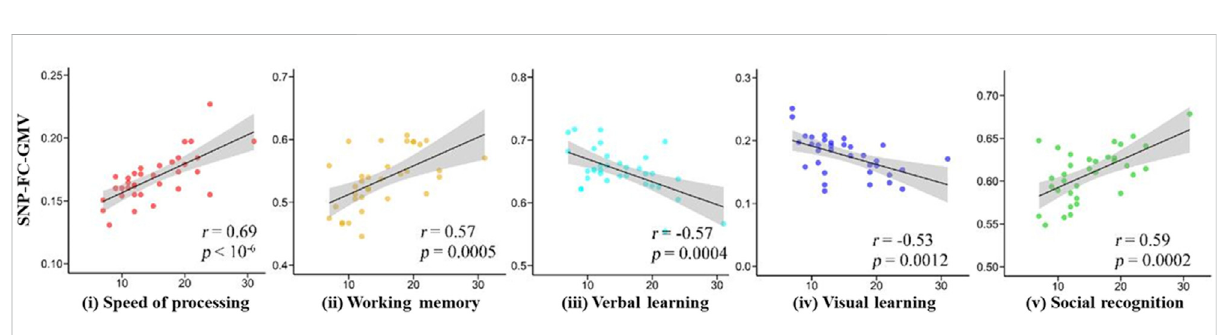
FIGURE 3 Five regions of interest with strong gFCD correlations with MCCB